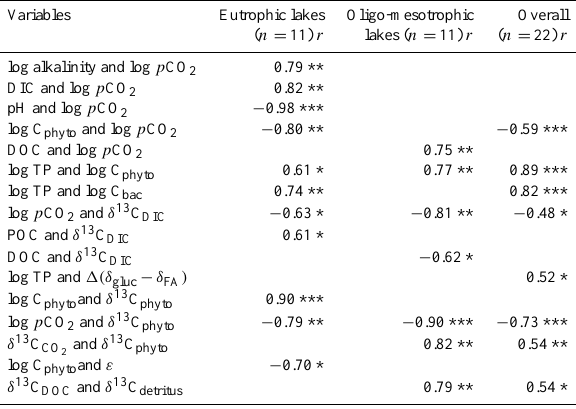
Table 2. Significant correlation coefficients ( r) between tested vari- ables in all lakes and in eutrophic and oligo-mesotrophic lakes